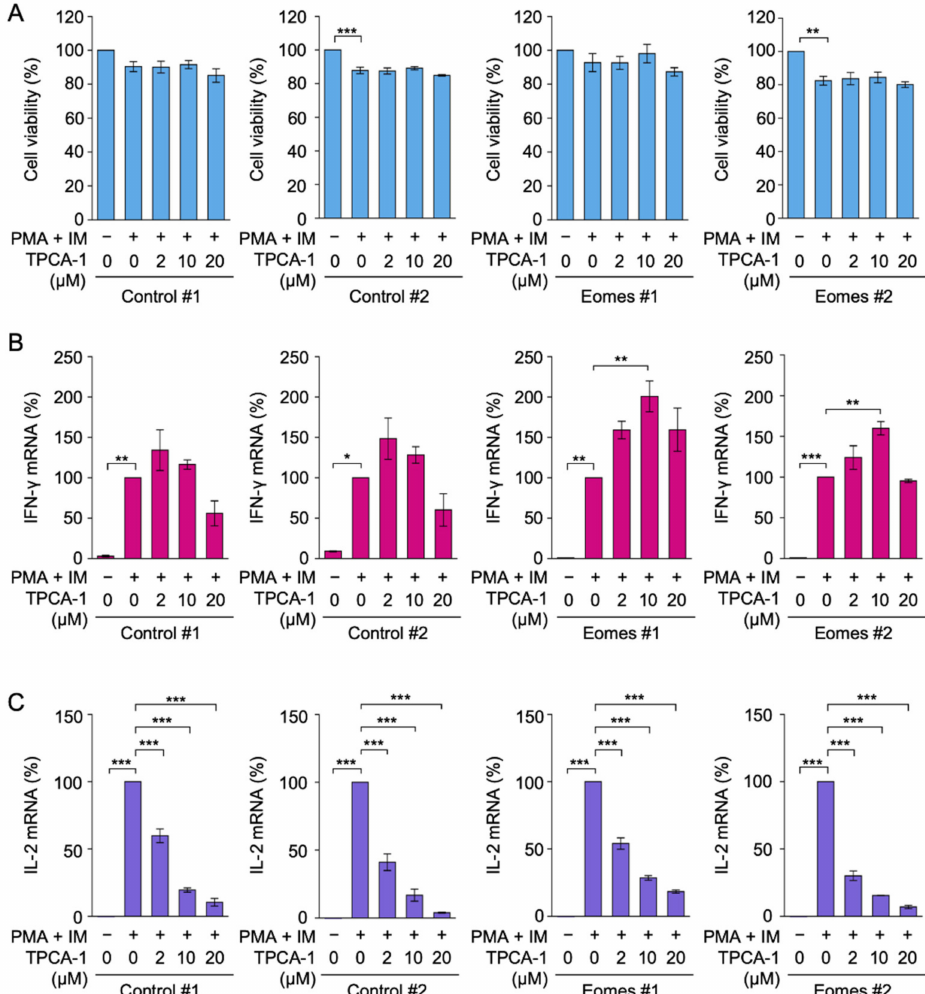
Figure 3. Effects of TPCA-1 on IFN- γ and IL-2 mRNA expression in EL4 transfectants. ( A – C ) Control #1, Control #2, Eomes #1, and Eomes #2 EL4 transfectants were pretreated with TPCA-1 for 1 h and then treated with (+) or without ( − ) PMA (10 nM) and IM (1 µ M) for 2 h in the presence or absence of TPCA-1 at the indicated final concentrations. Cell viability (%) is shown as the mean ± S.E. of three independent experiments ( A ). IFN- γ mRNA ( B ) and IL-2 mRNA ( C ) were measured by quantitative PCR. mRNA levels with PMA and IM in each EL4 transfectant were set to 100%. IFN- γ mRNA (%) and IL-2 mRNA (%) are shown as the mean ± S.E. of three independent experiments. * p < 0.05, ** p < 0.01, and *** p <